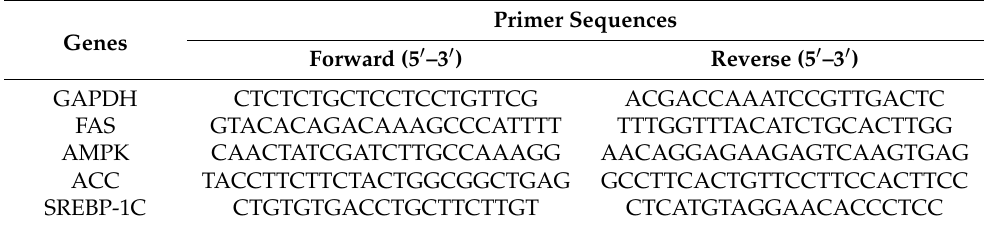
Table 2. Primer sequences used for